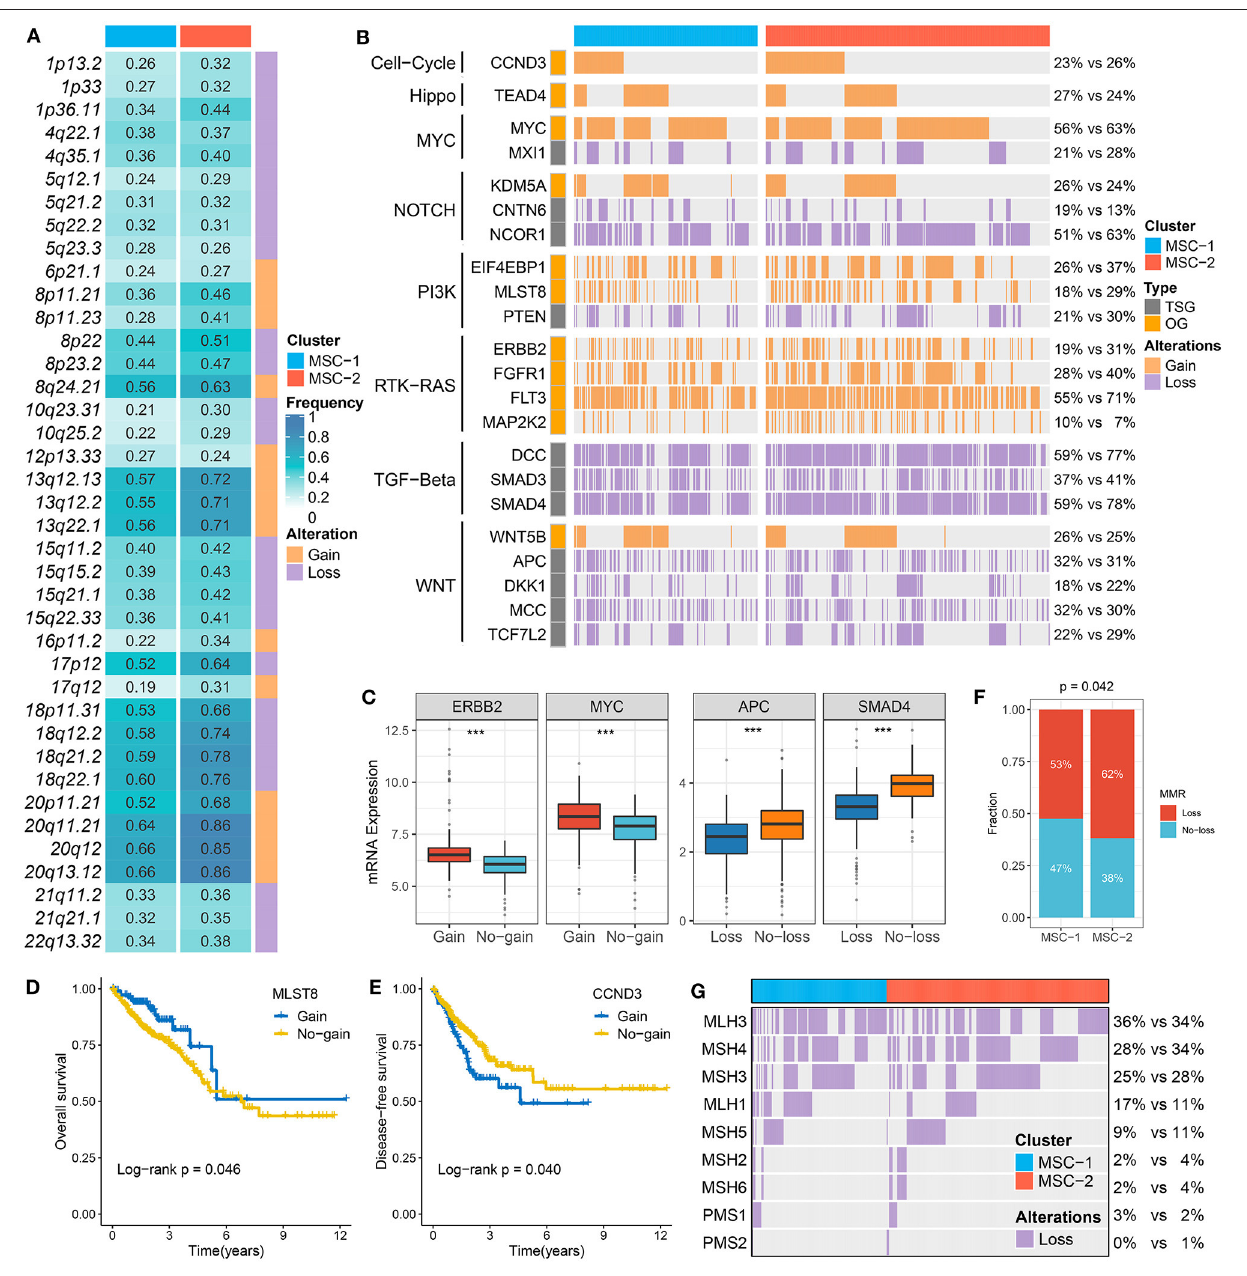
FIGURE 3 | The driven segments identified from GISTIC algorithm in CRC. (A) The amplification (orange) and deletion (purple) frequency of 39 driven segments in two subtypes. (B) The distribution of CNA relevant oncogenes and tumor suppressive genes in two subtypes. (C) The expression difference of ERRB2 and MYC between the gain and no-gain groups, as well as APC and SMAD4 between the loss and no-loss groups. *** P < 0.001. (D,E) Kaplan–Meier survival analysis of MLST (D) and CCND3 (E) gain. (F) The relative proportion of patients with the MMR genes deletions in two subtypes. (G) Oncoplot for the deletion of nine MMR-related genes in two